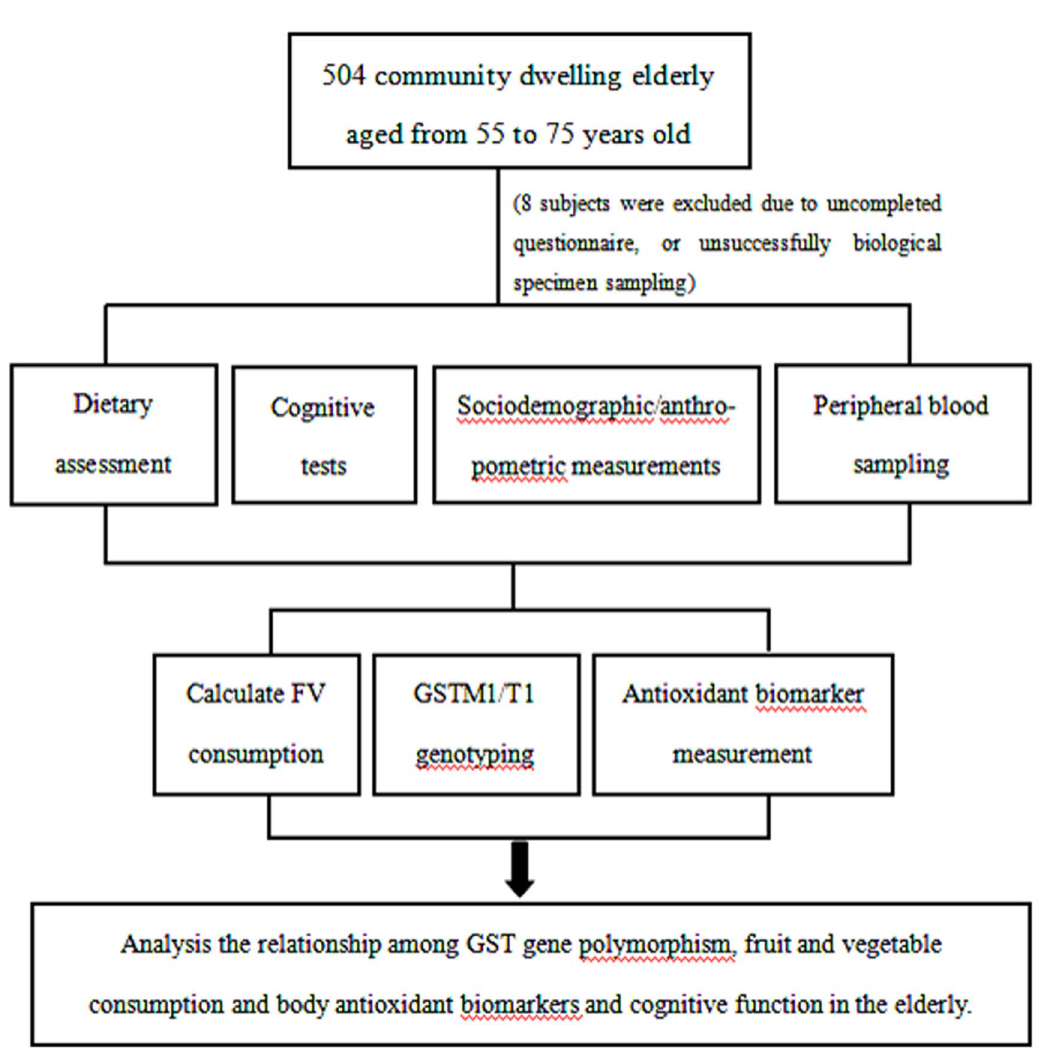
Figure 1. Graphic presentation of the overall